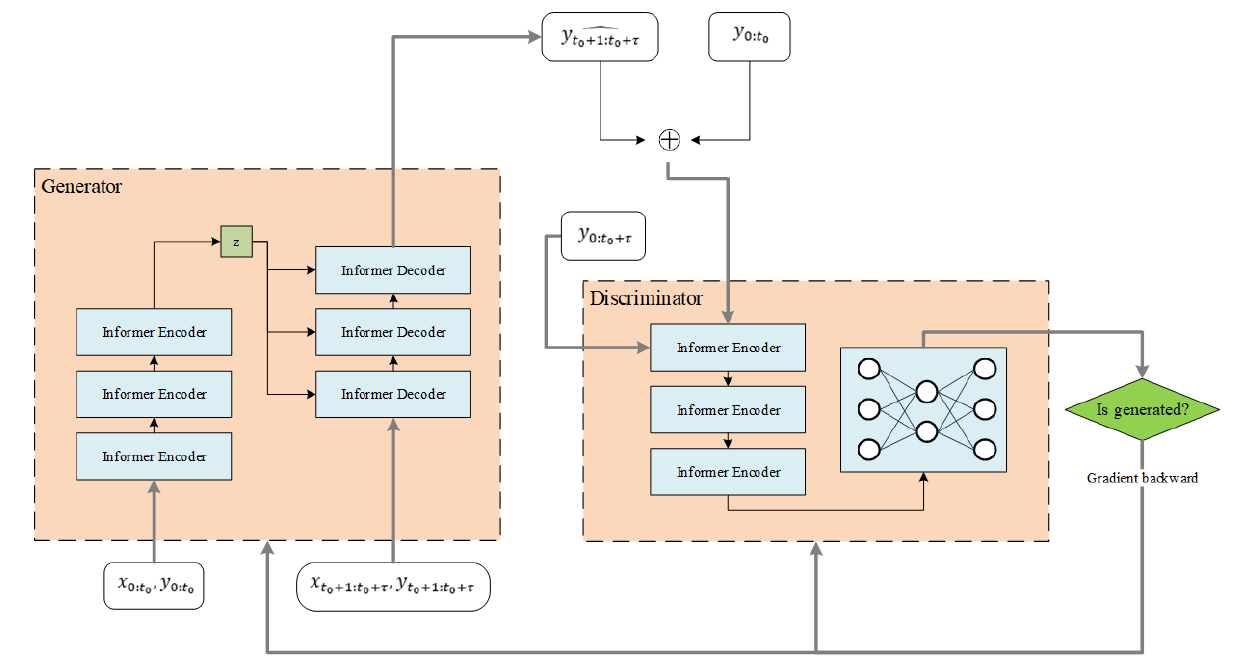
Figure 1. Informer-WGAN